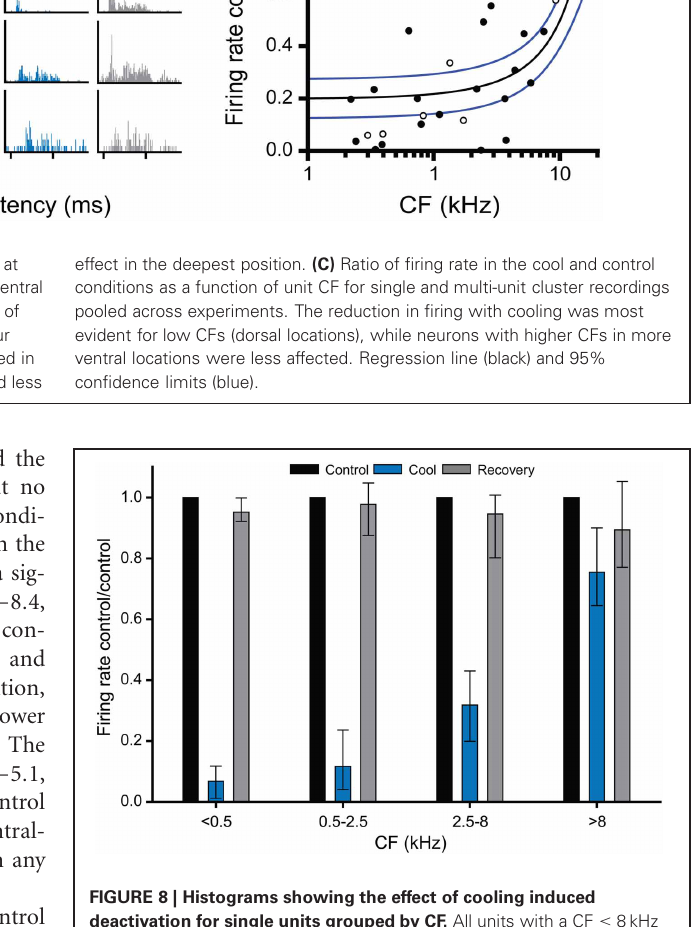
FIGURE 8 | Histograms showing the effect of cooling induced deactivation for single units grouped by CF. All units with a CF ≤ 8kHz showed a statistically significant reduction in firing on cooling re their control (pre-cool) values, whereas units with CF > 8kHz did not show a statistically significant reduction in firing during cooling. In all cases firing rates recovered close to control values on